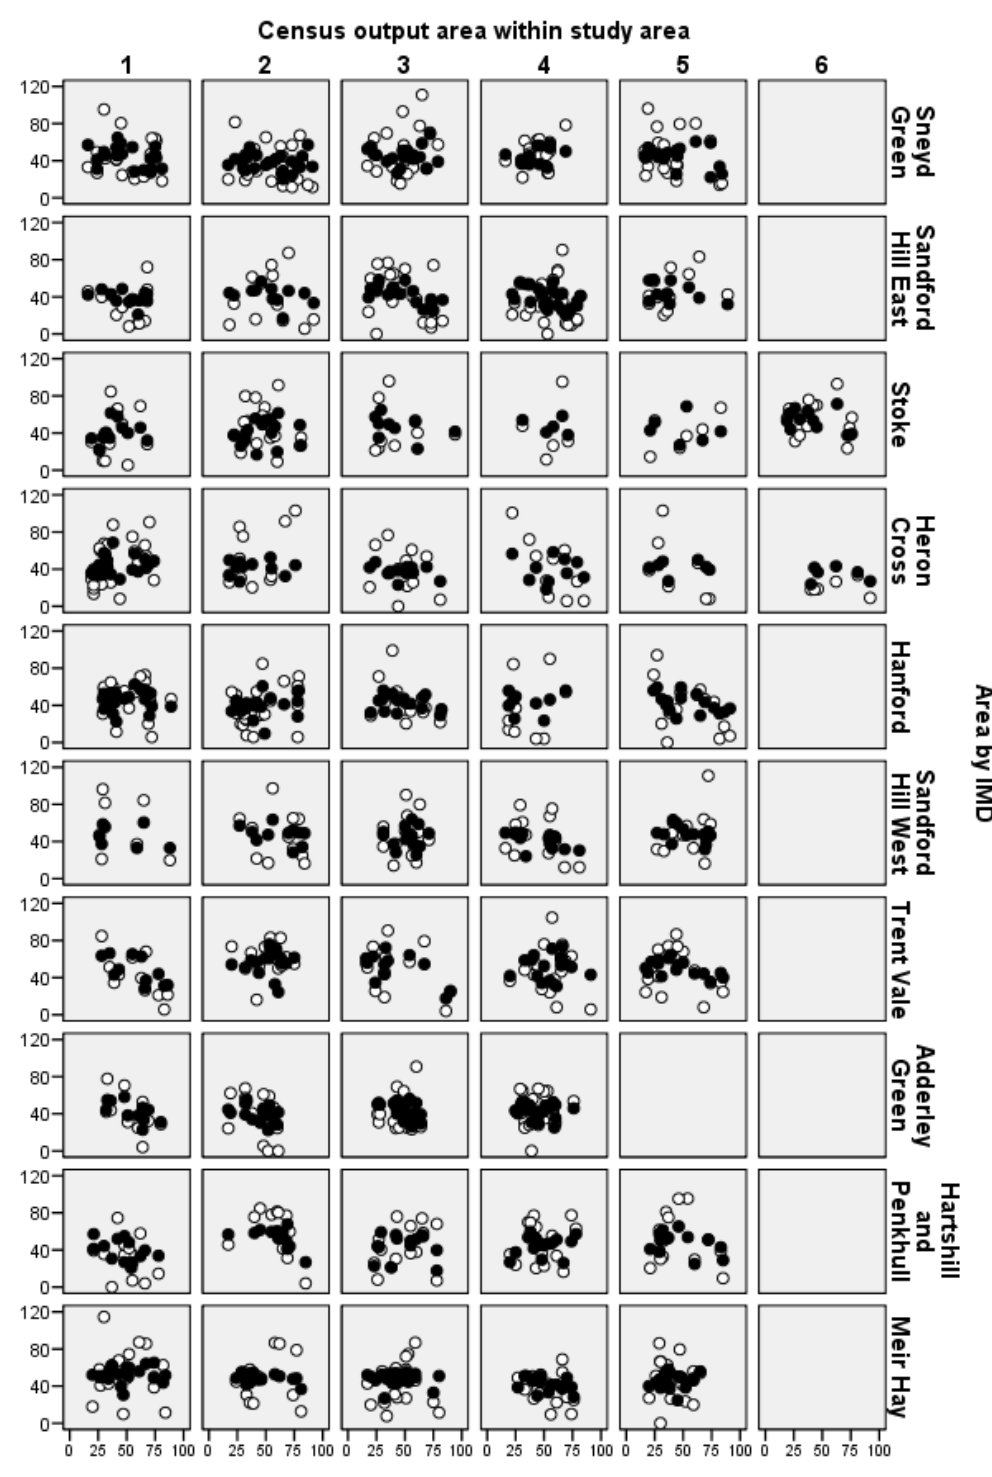
Figure 1. Activity outside work (transformed) vs age (years) within the 51 study areas. Key: ○ - actual data, ● - multi-level fit